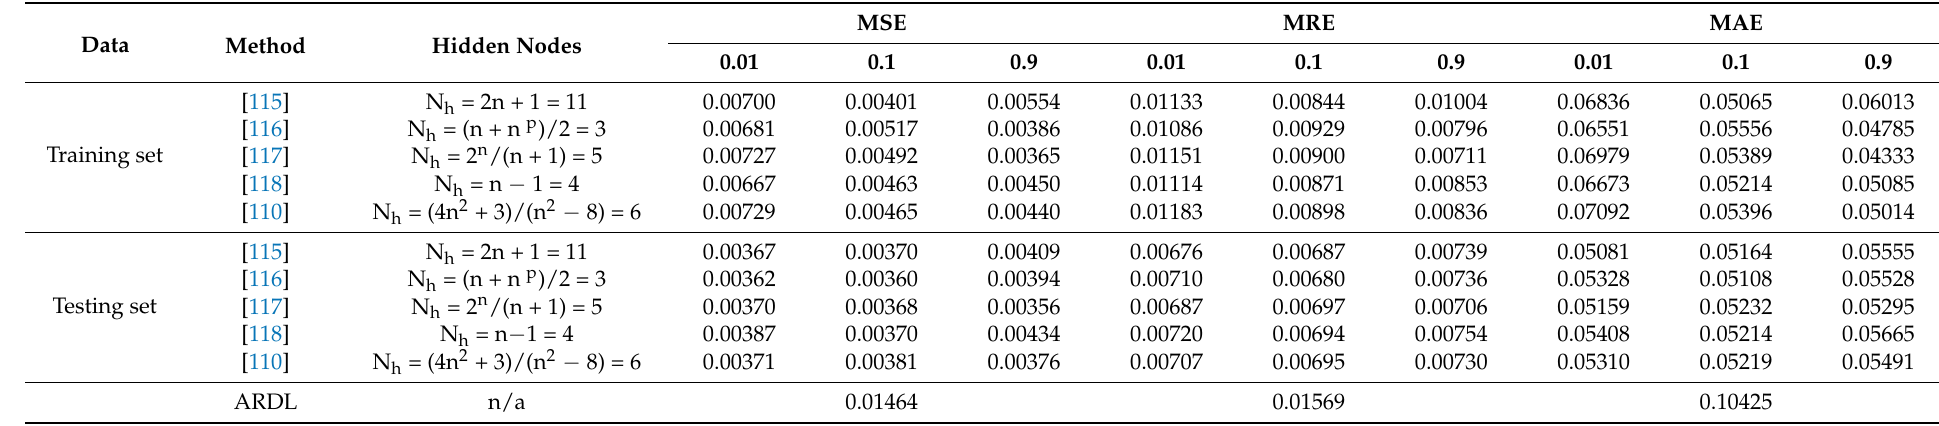
Table 7. Criteria for